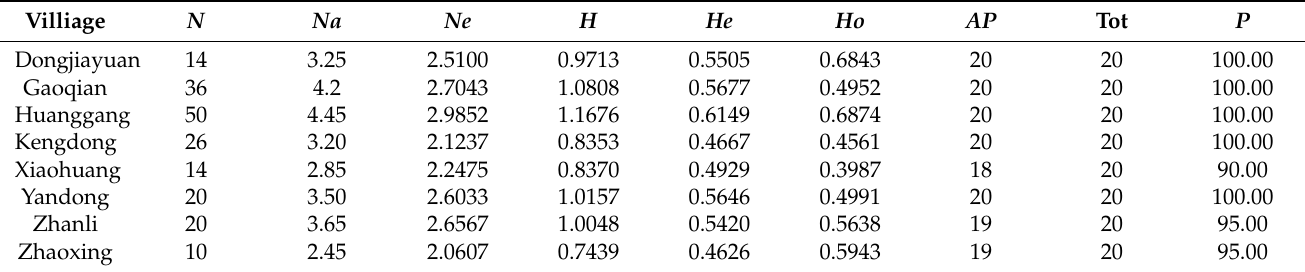
Table 2. Genetic diversity of Kam fragrant glutinous rice in different Dong